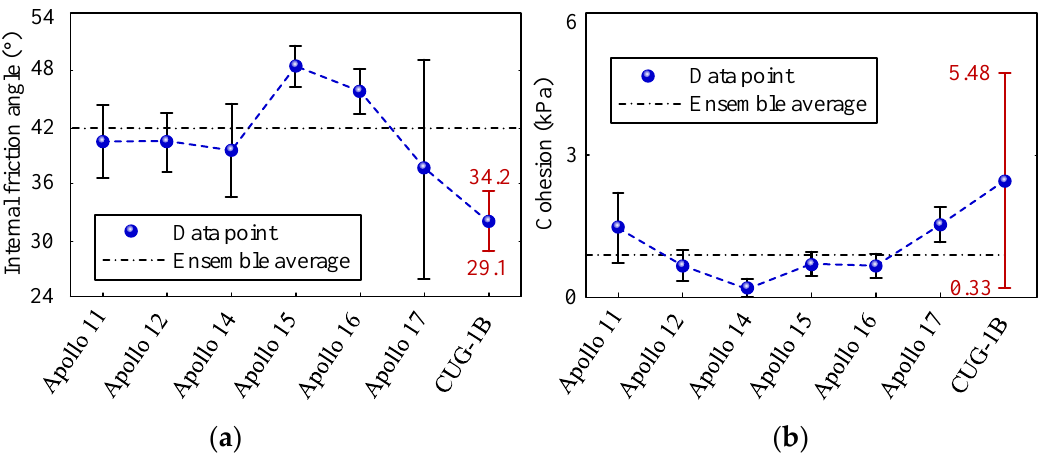
Figure 3. The comparison on internal friction angle and cohesion of lunar soil simulant and lunar regolith: ( a ) comparison on internal friction angle; ( b ) comparison on cohesion.